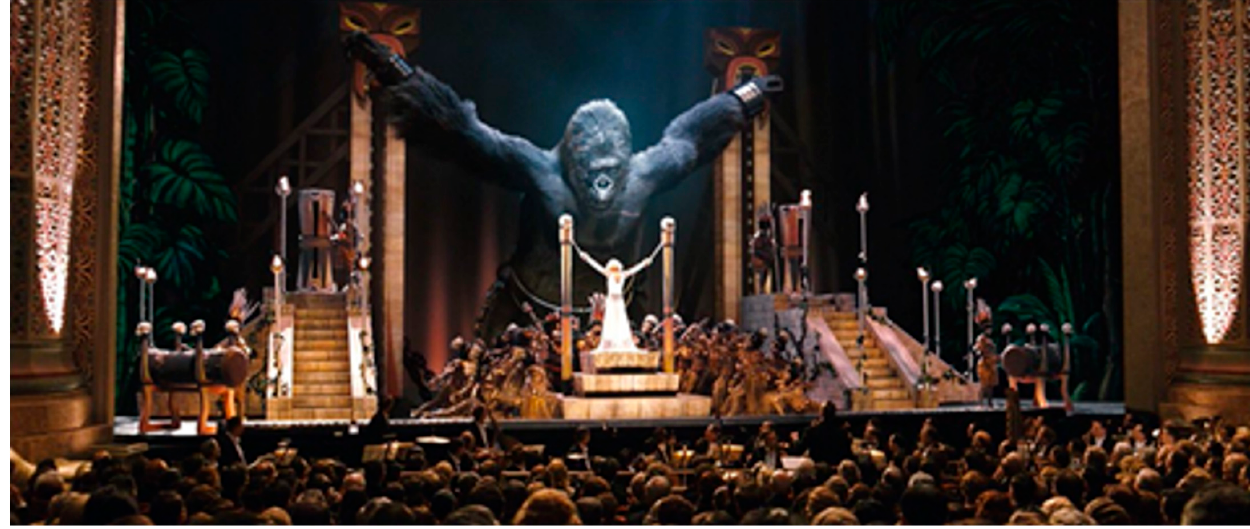
Figure 21. The double sacrifice, King Kong and the female protagonist (2005). https://twitter.com/login/error?username_or_email=melin2000&redirect_after_login=%2Fcinemartistry%2Fstatus%2F867802830735888384 (accessed on 1 January 2021).